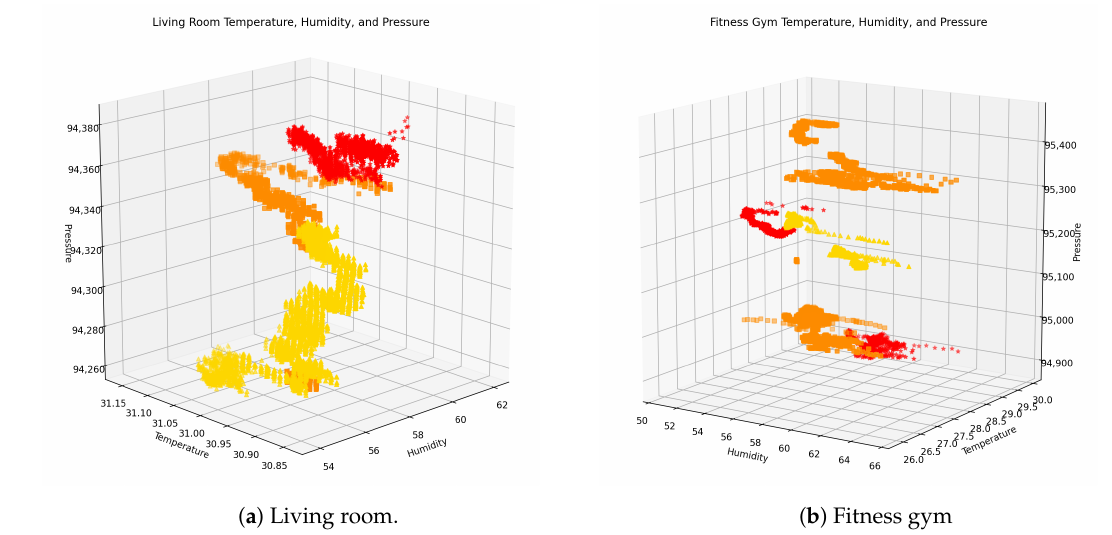
Figure 4. 3D scatter plot based on the ( a ) living room and ( b ) fitness gym data. The occupancy levels are indicated as follows: low (yellow), medium (orange), and high